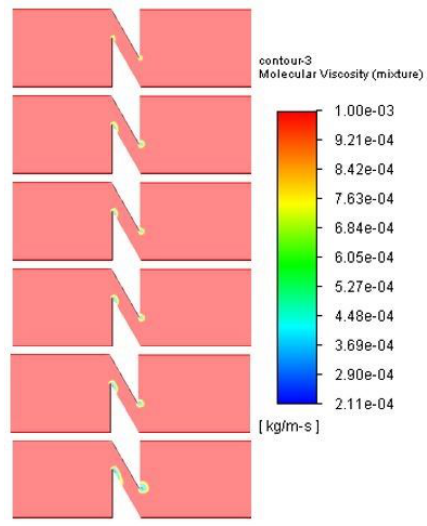
Figure 9: Contour of molecular viscosity at different inlet pressures (1–6